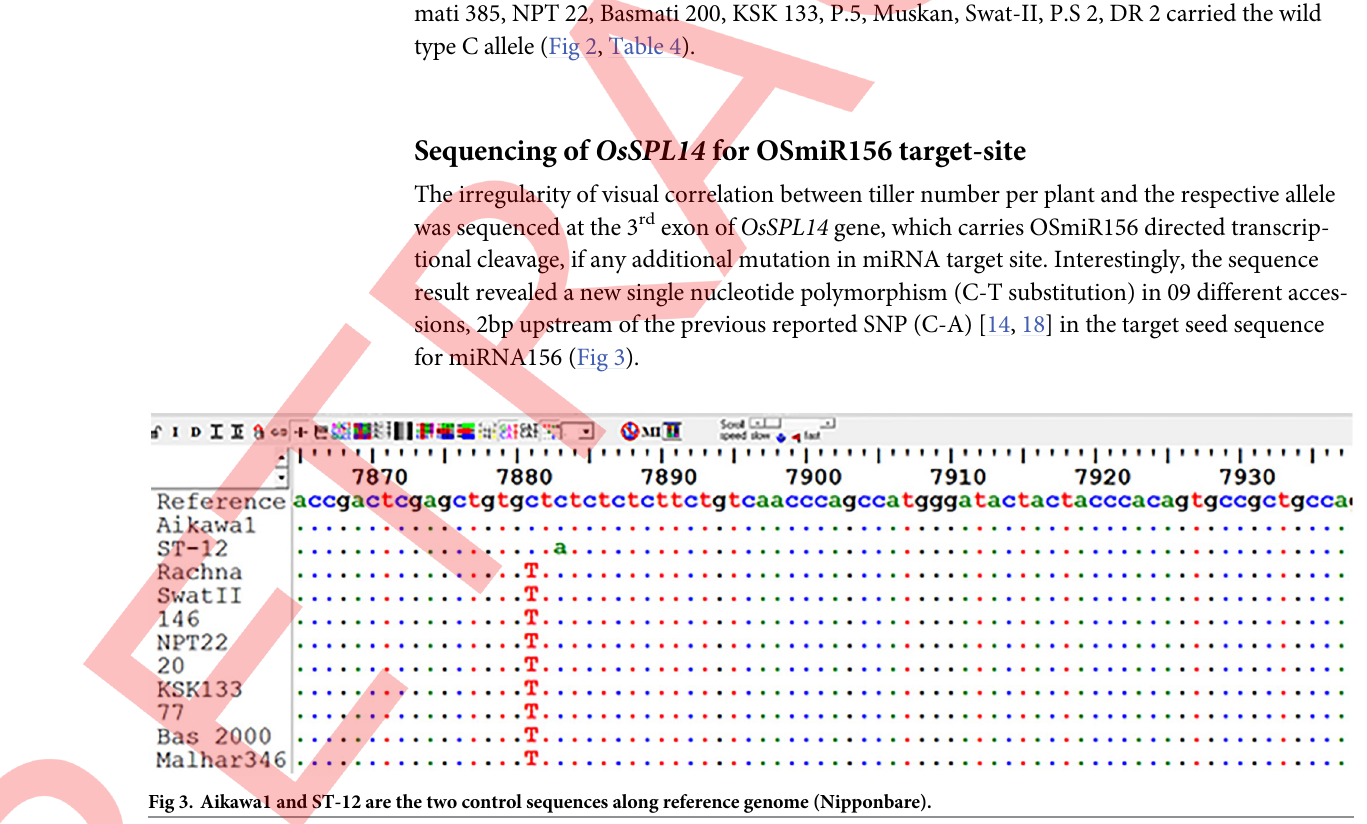
type C allele (Fig 2, Table 4).